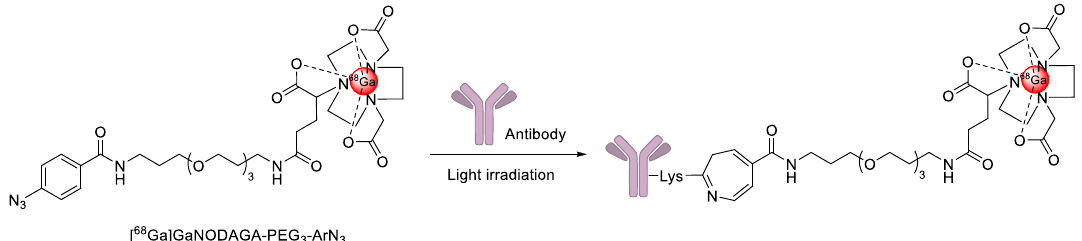
Figure 21. Radiolabeling of antibodies using photochemical conjugation reaction.